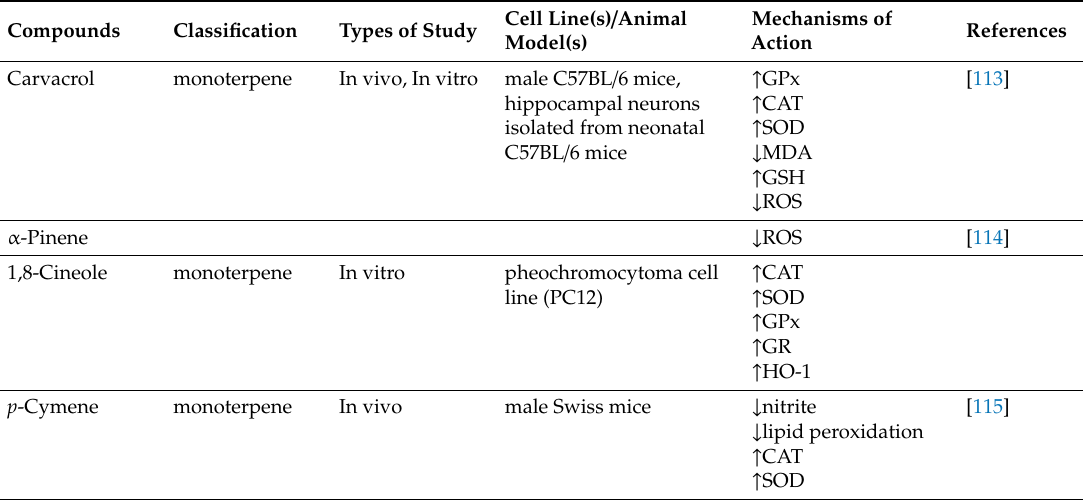
Table 3. Terpenes and terpenoids in combating AD through Nrf2 / keap1 / ARE and interconnected